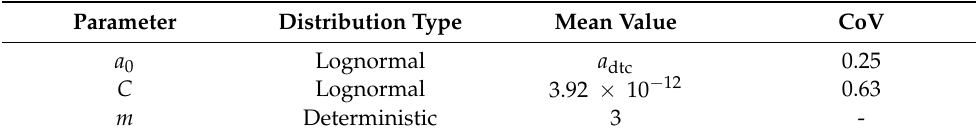
Table 2. Statistical distribution of parameters related to crack